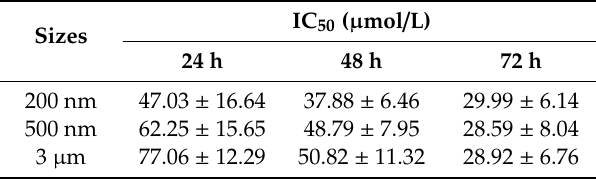
Figure 2. Characterization of cell proliferation. ( a ) Effect of different concentrations of QE-NCs on the proliferation of A549 cells. ( b ) Effect of different particle sizes of QE-NCs on the proliferation of A549 cells ( n = 6). ( a ) E ff ect of di ff erent concentrations of QE-NCs on the proliferation of A549 cells. ( b ) E ff ect of di ff erent particle sizes of QE-NCs on the proliferation of A549 cells ( n = 6). Table 2. The IC 50 values of QE-NCs of different particle sizes on A549 cells ( n = 6). Table 2. The IC 50 values of QE-NCs of di ff erent particle sizes on A549 cells ( n = 6). Sizes